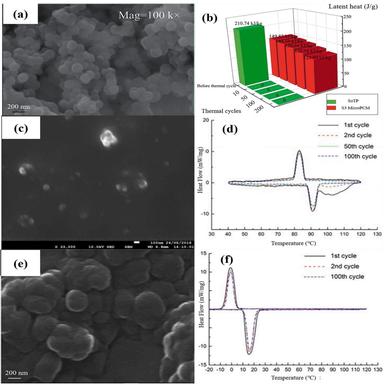
(a) SEM of microcapsule hydrated salt PCM containing Na2S2O3⋅5H2O, (b) latent heat values of pure Na2S2O3⋅5H2O and microcapsule hydrated salt PCM containing Na2S2O3⋅5H2O before and after thermal cycles , (c) SEM of nanocapsule PCM containing Mg(NO3)2⋅6H2O, (d) DSC curves of nanocapsule PCM containing Mg(NO3)2⋅6H2O before and after thermal cycles, (e) SEM of nanocapsule with Mg(NO3)2⋅6H2O and Na2SO4⋅10H2O of 1:1 mass fraction and (f) DSC curves of nanocapsule with Mg(NO3)2⋅6H2O an